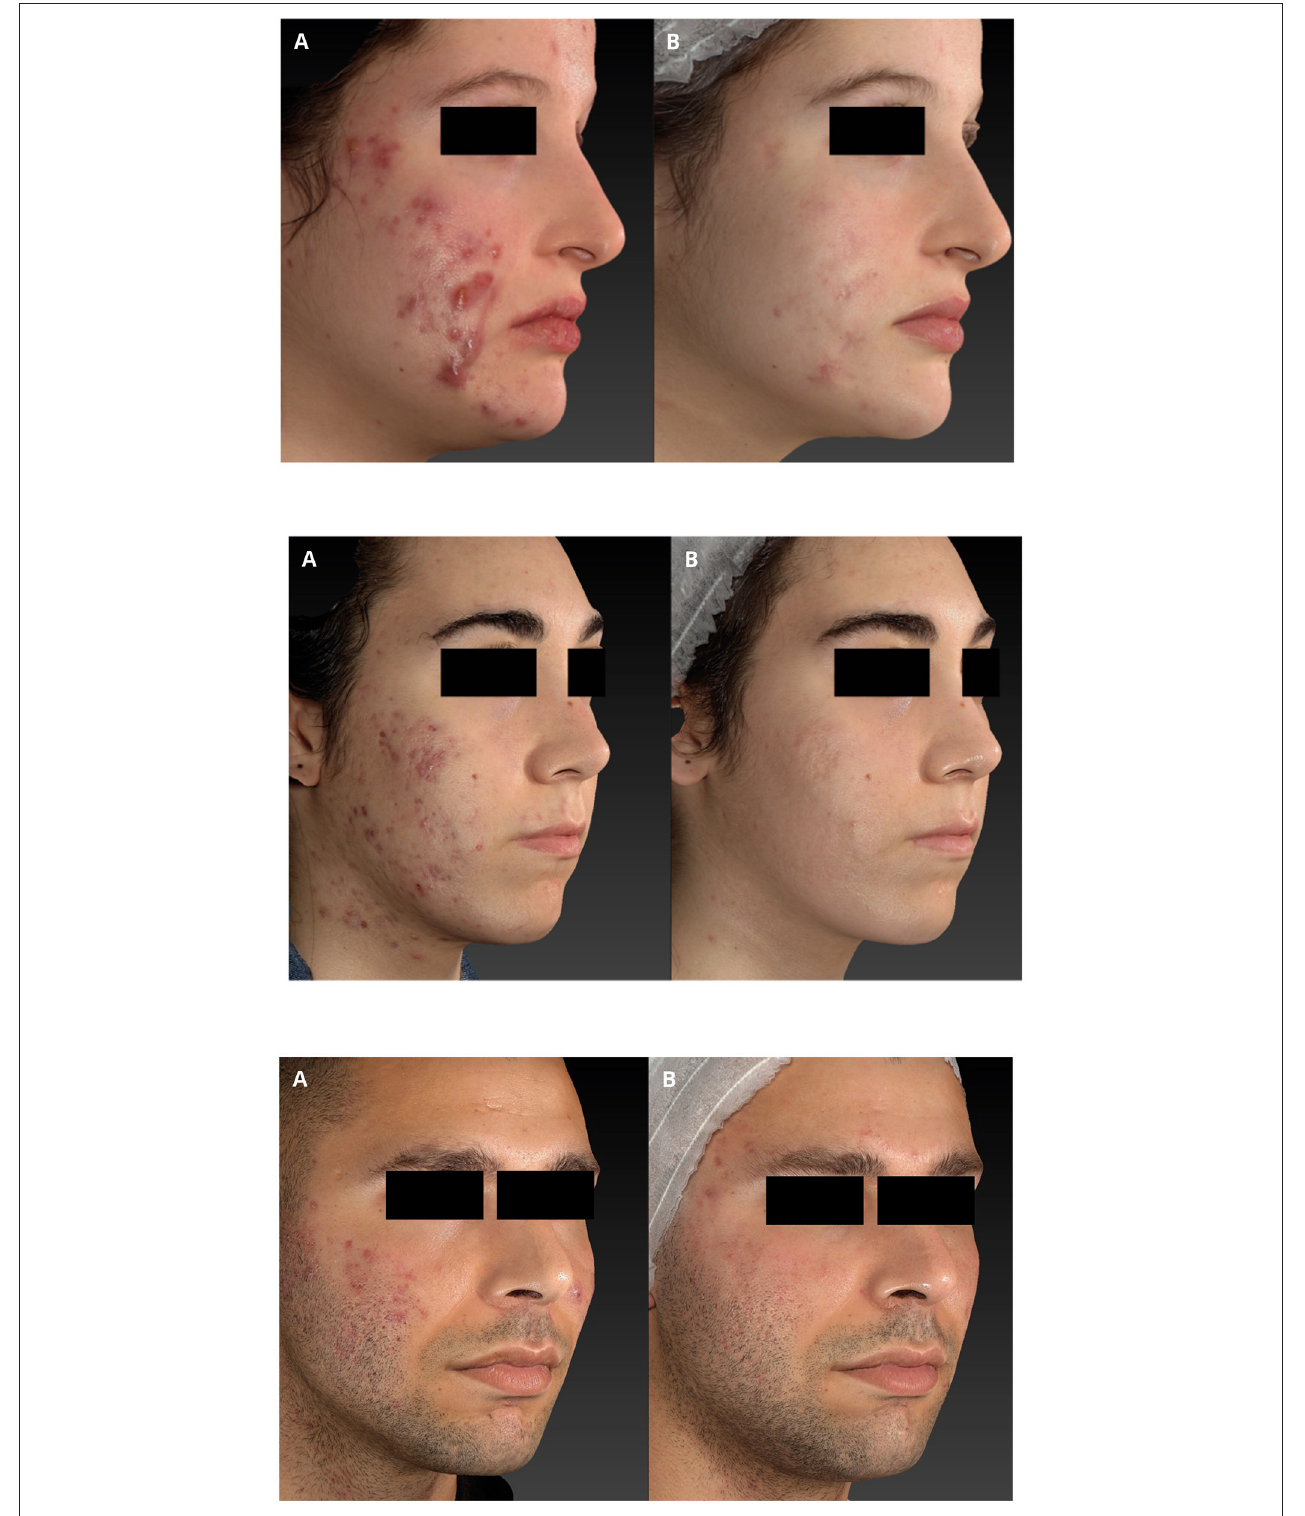
FIGURE 1 | Nodulocystic acne before (A) and after (B) 4 sessions of IPL treatment (wavelength 400nm) (top panel); Papulo-pustolous acne before (A) and after (B) 5 sessions of IPL treatment with notable improving of active acne lesions and acne scars (middle and bottom panel).